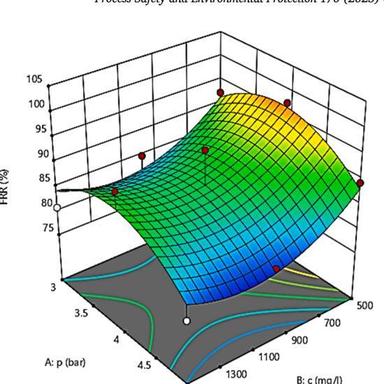
Plots of (a) 3D surface in dark condition; (b) 3D surface in light irradiation; (c) predicted vs. actual values for flux response.